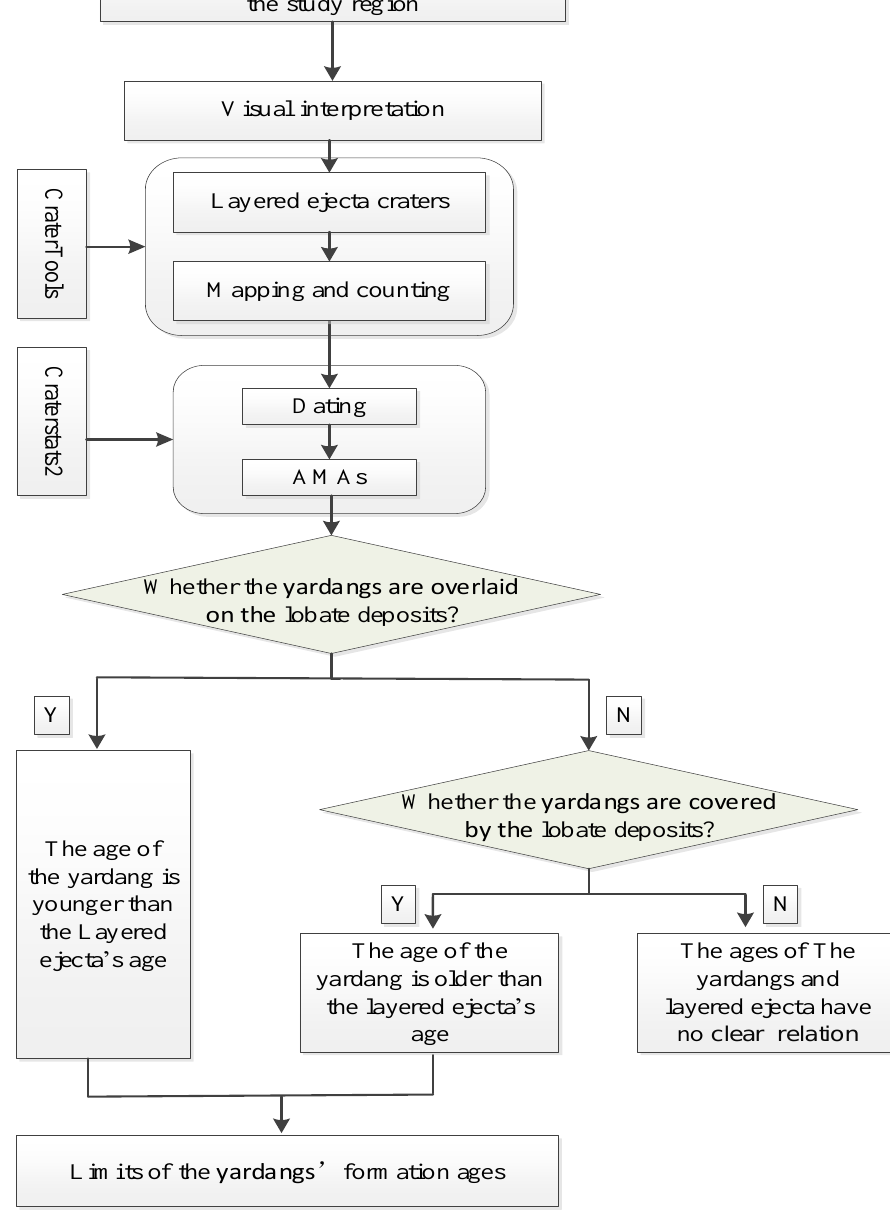
Figure 3. Flowchart of the process for constraining the yardangs formation age.